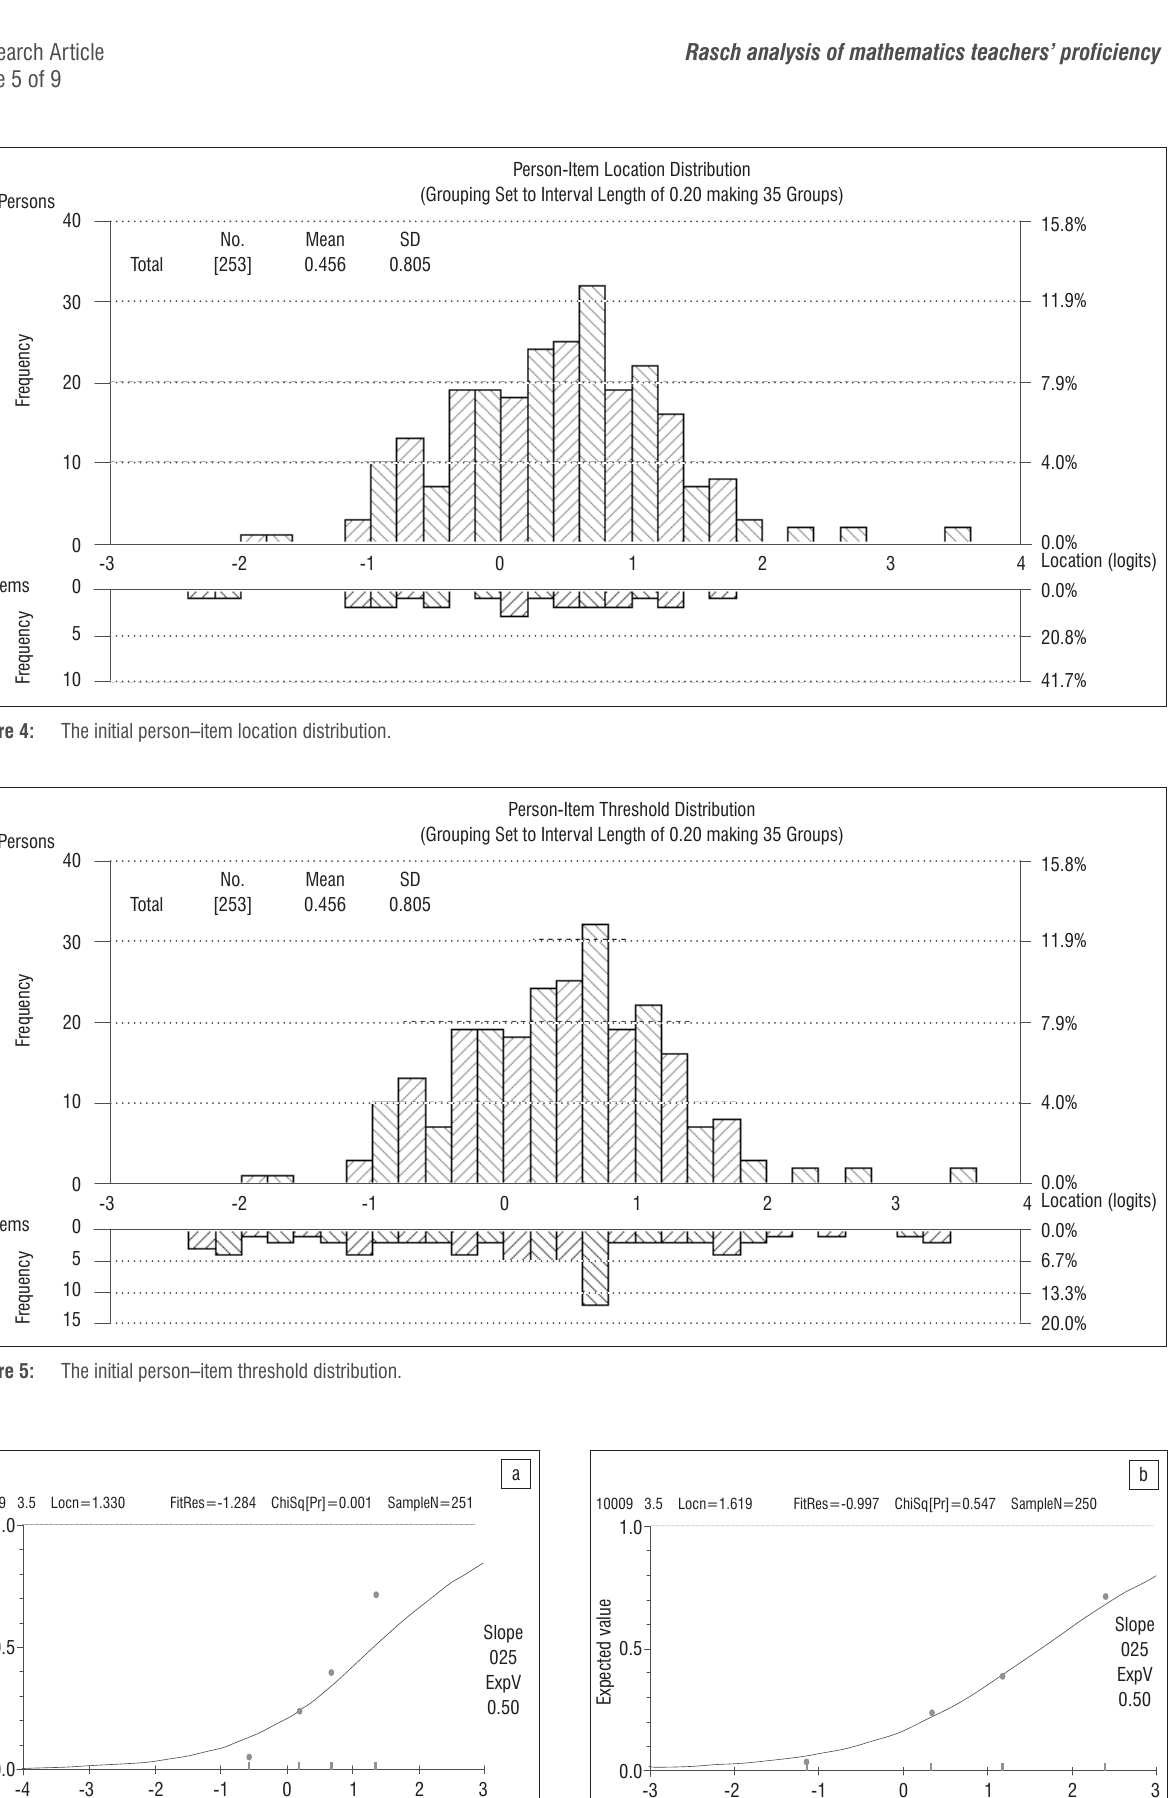
Person Location (logits) Figure 6: (a) Initial and (b) final item characteristic curve (ICC) for Item 3.5. The ICC in the original shows over discrimination. After a process of rescoring, the empirical distribution on the ICC shows much better fit, which is confirmed by the fit residual statistic which has moved from -1.284 to